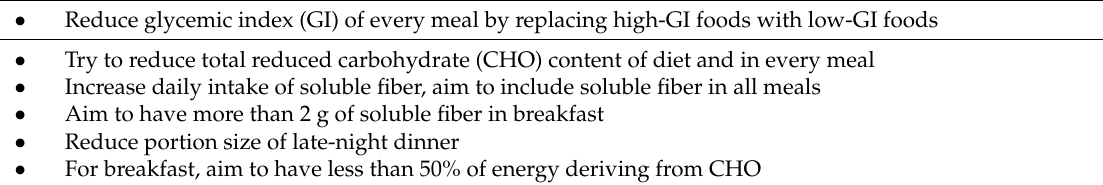
Table 4. Practical nutrition recommendations for improving postprandial hyperglycemia in type 2 diabetes